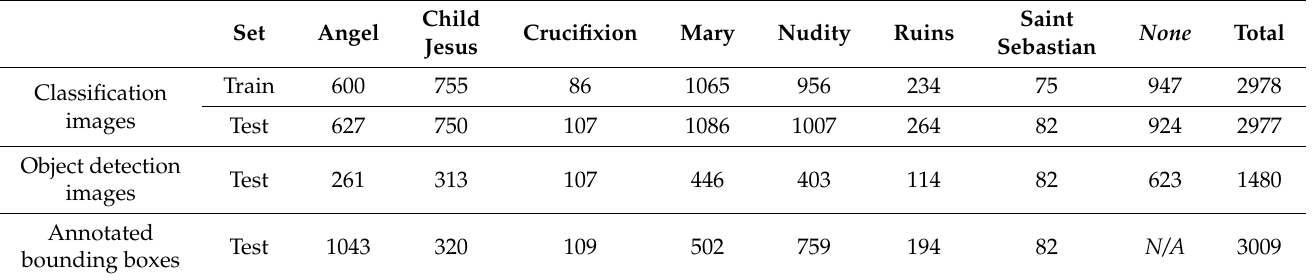
Table 2. The IconArt data set —The number of images is shown per class and per task (classification and object detection). For object detection, the number of annotated bounding boxes is reported